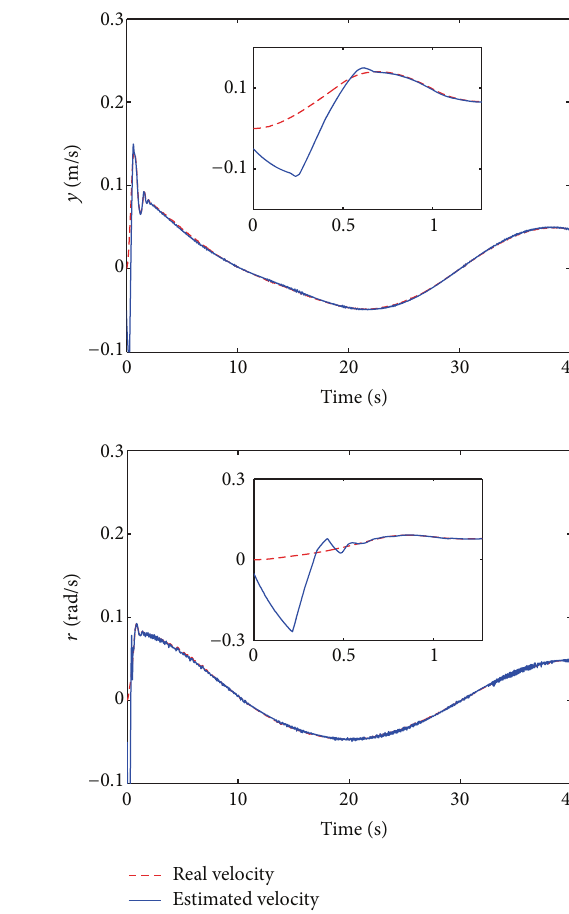
Figure 4: Estimated velocity and real velocity of output feedback